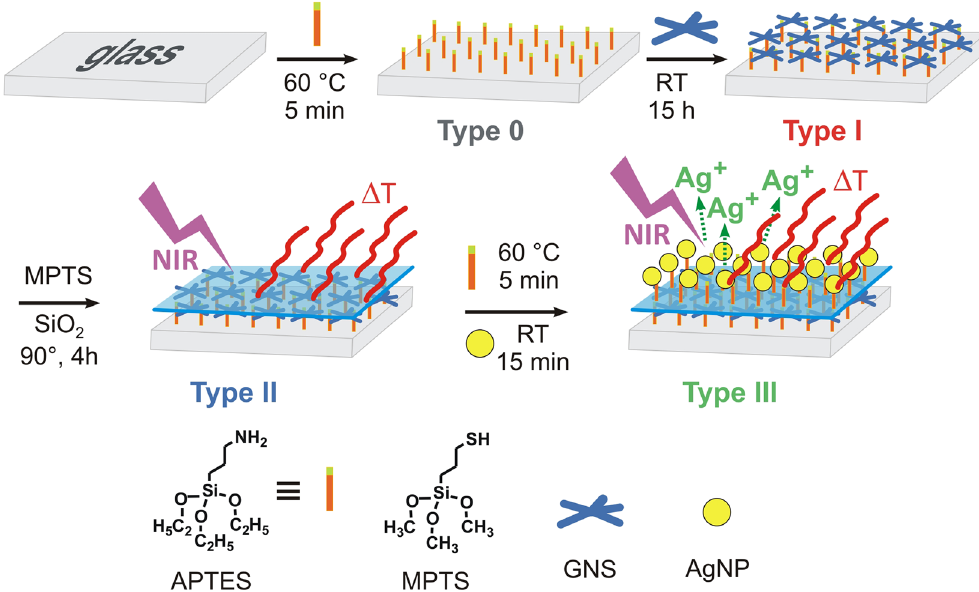
Figure 1. Synthetic route for the preparation of Type I-III surfaces (experimental details are described in the Methods section and in the Supporting Information). Type 0: amino-functionalised glass. Type I: gold nanostars (GNS) monolayer on glass. Type II: SiO 2 -coated GNS monolayer. Type III: Silver nanoparticles (AgNP) decorated surface with underlying monolayer of